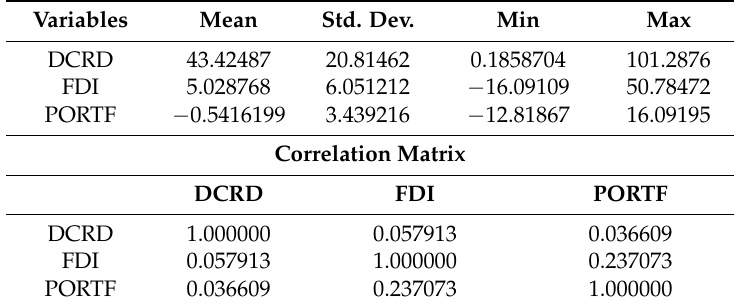
Table 2. Descriptive statistics and the correlation matrix of the variables in the